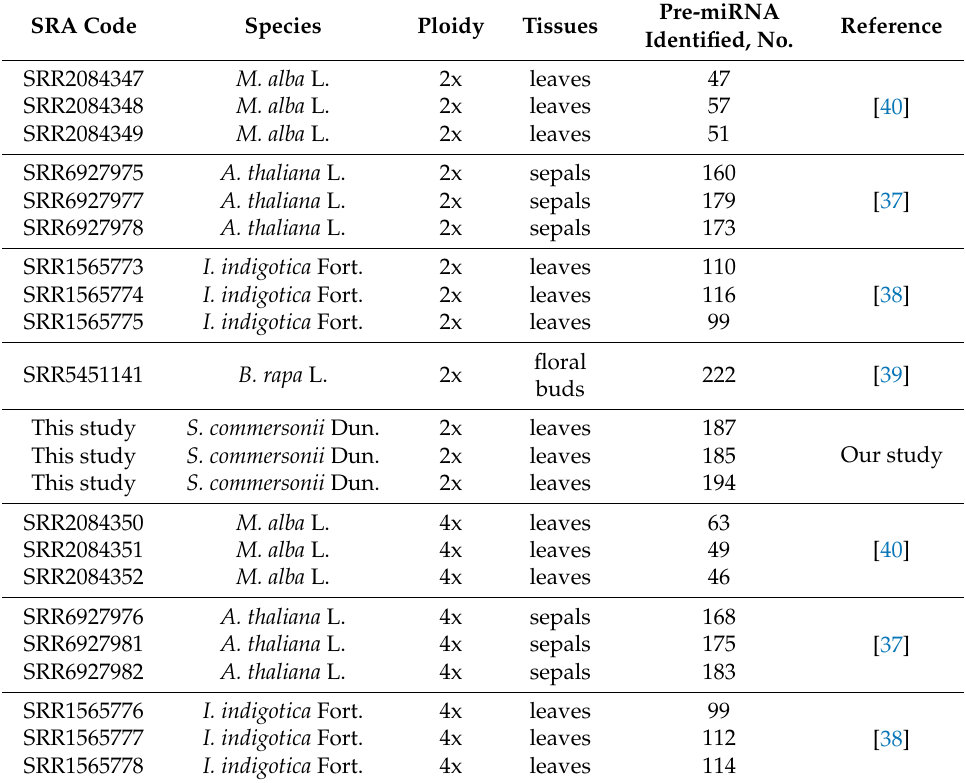
Table 1. Number of identified pre-miRNAs. Tissues used in each experiment along with ploidy level are also